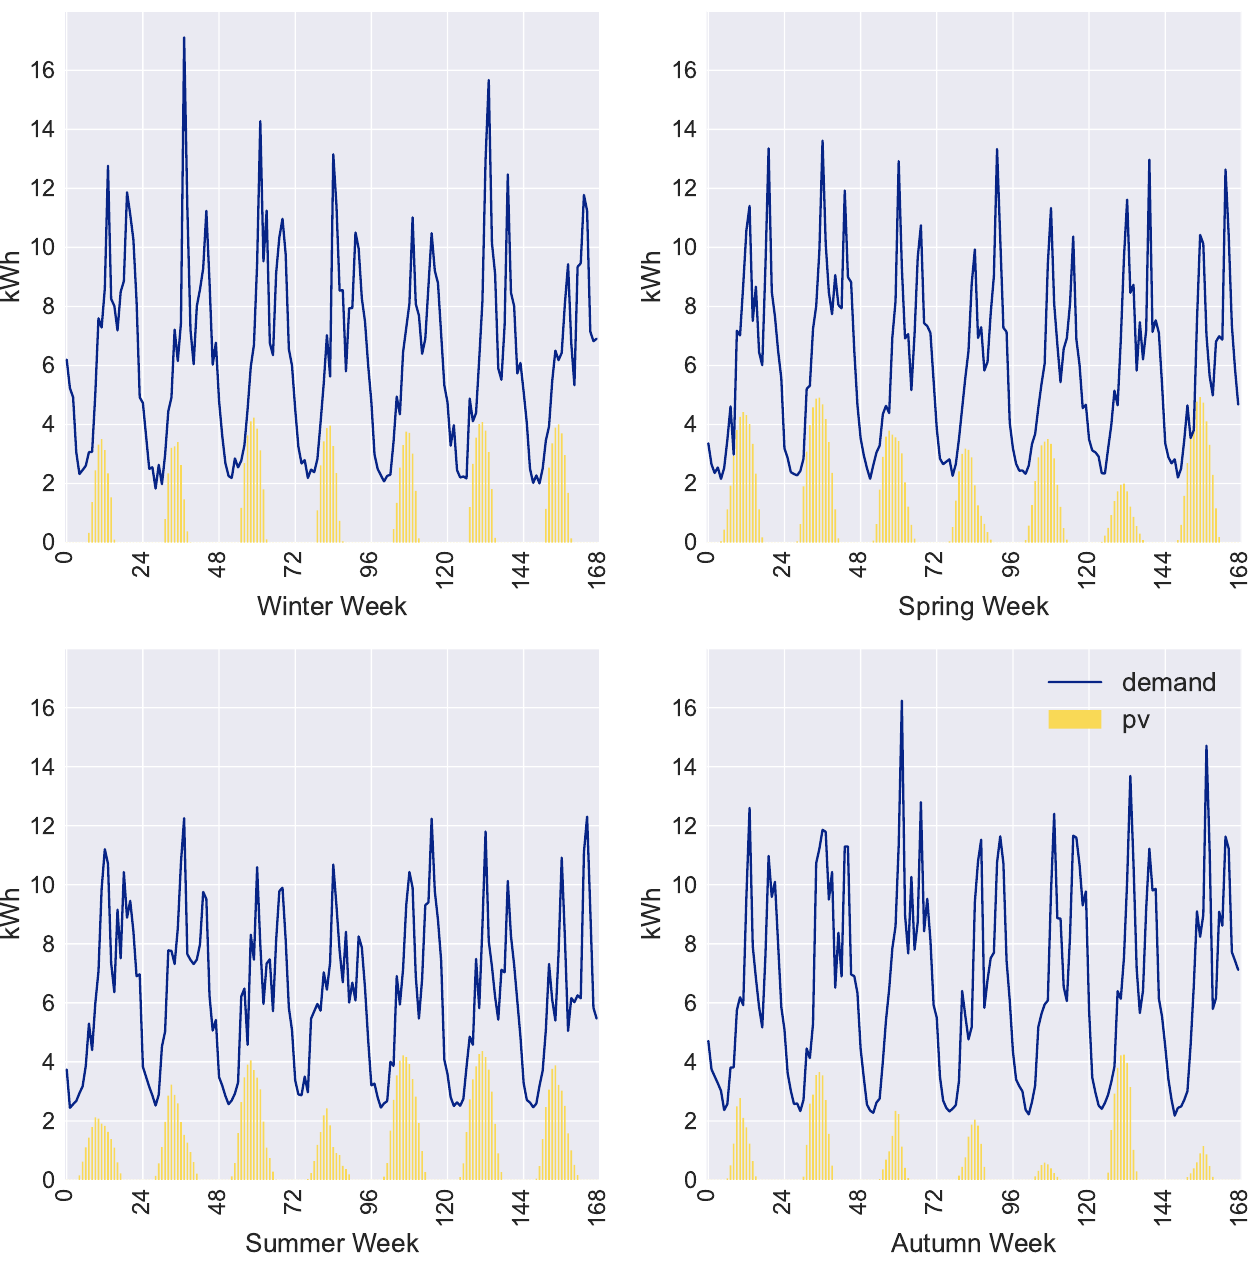
Figure A7. Weekly electricity production per technology source: Location